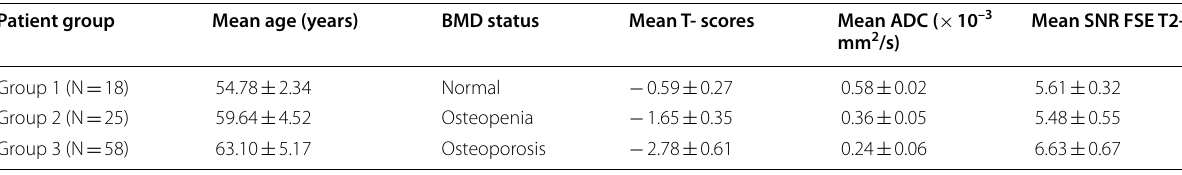
Table 1 Bone marrow diffusion and DXA results Patient group